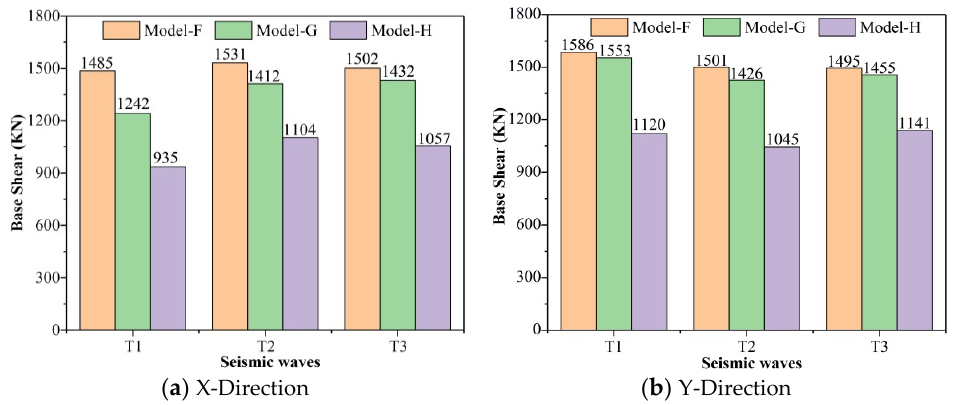
Figure 20. The maximum base shear of the models.